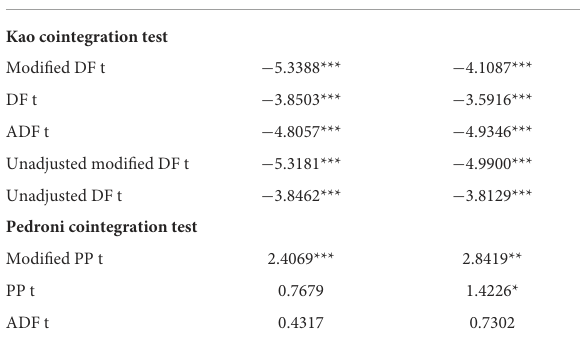
TABLE 5 Cointegration